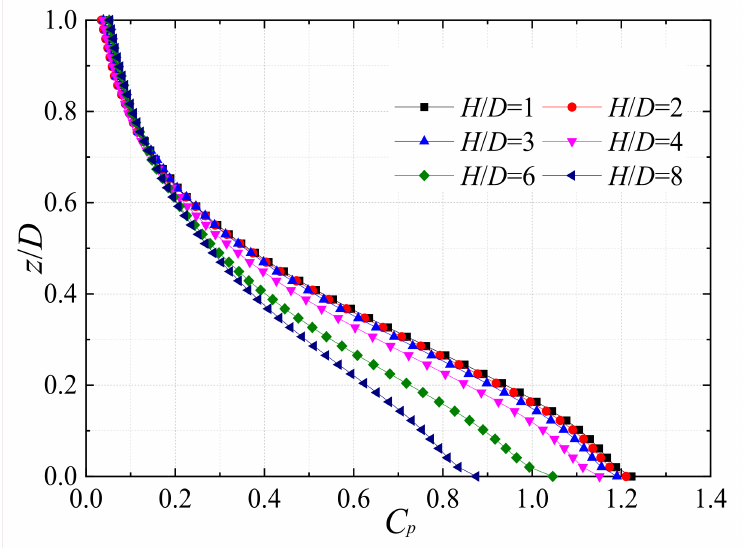
Figure 16. Distribution of the axial pressure coefficient C p of the jet in the impingement